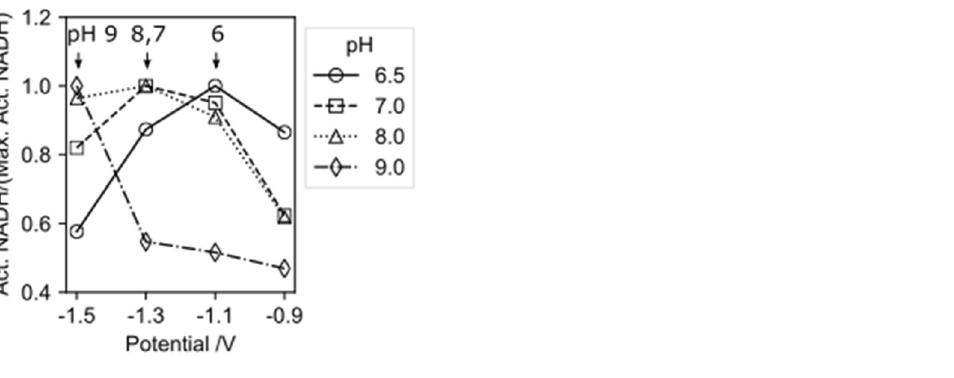
Figure 5. Normalised amount of active NADH over the electrode potential for different solution pHs. Arrows indicate the tipping potential for the different solution pHs. The normalised active NADH was calculated by dividing the active NADH by the maximum active NADH of each